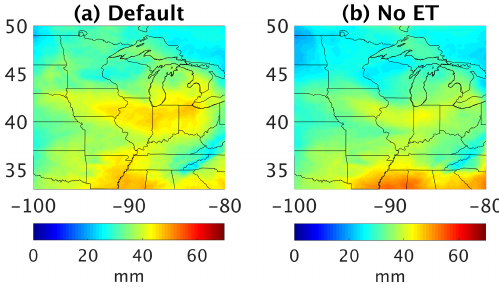
Figure 9. WRF simulations of TCWV (mm) for the Midwestern US on 21 July 2016 for the run (a) with and (b) without evapotranspi-